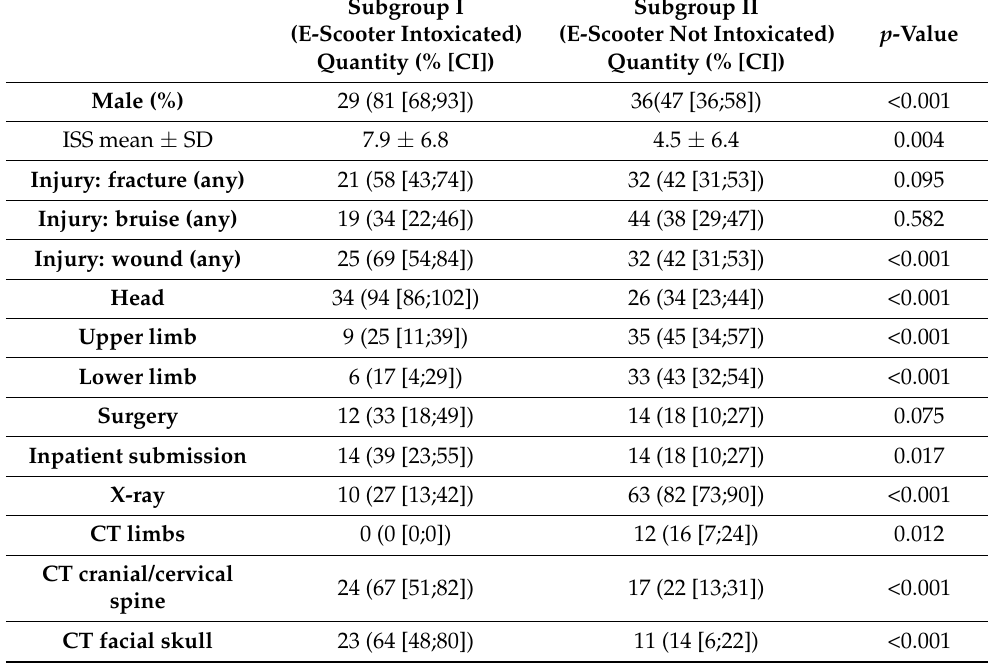
Table 3. Subgroup